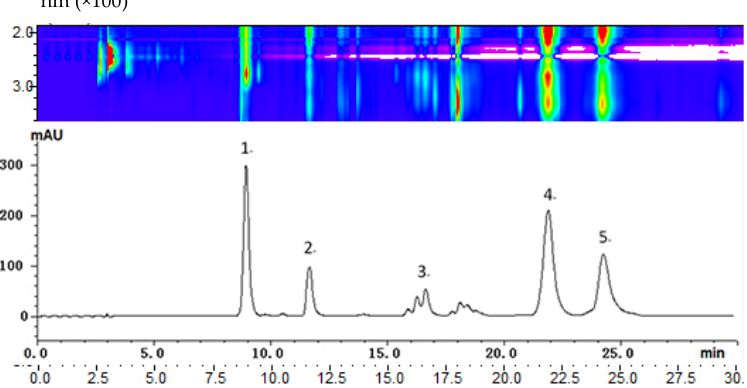
Figure 3. The HPLC chromatogram of the red cabbage extract was recorded at 520 nm, and the two-dimensional spectra were covered at 200–800 nm.